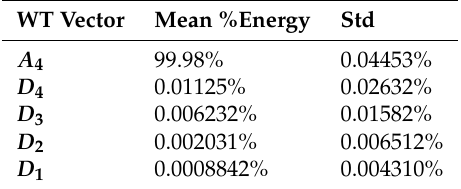
Table 3. Average percent energy of wavelet coefficient